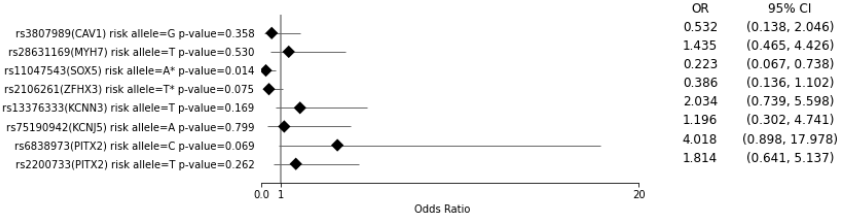
Figure 2. AF recurrence risk after DCC treatment per single tested variant. The odds ratio (OR) and 95% confidence interval (CI) are from the multivariate logistic regression analysis ( n = 97) (Table S3). * Alleles with p < 0.1 and OR < 1 consequently flipped for PRS.